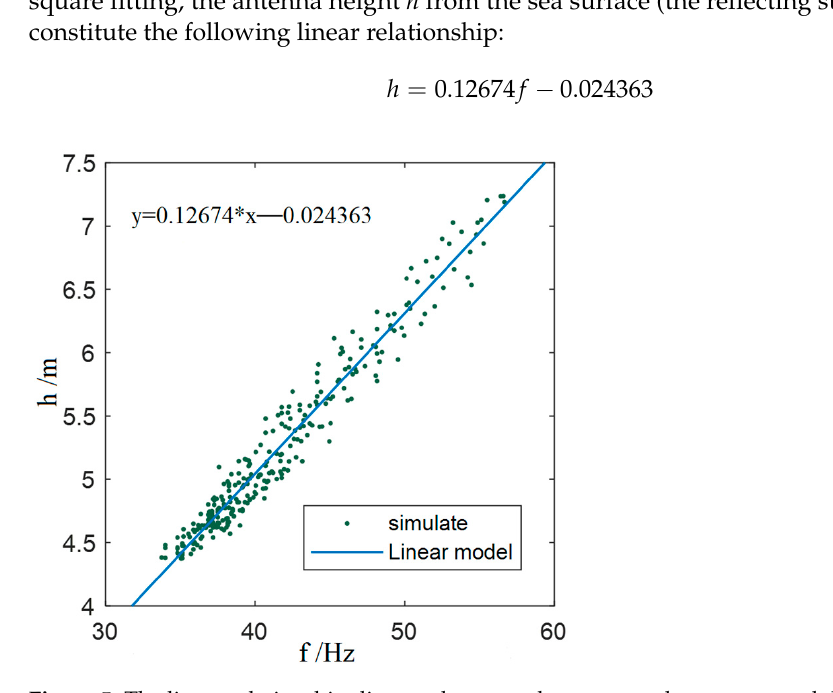
Figure 4. Periodic diagram ( a ) The triple-frequency combined-phase observation and ( b ) the Lomb- Scargle spectrum; sin e is the sinusoidal value of the satellite altitude angle e .